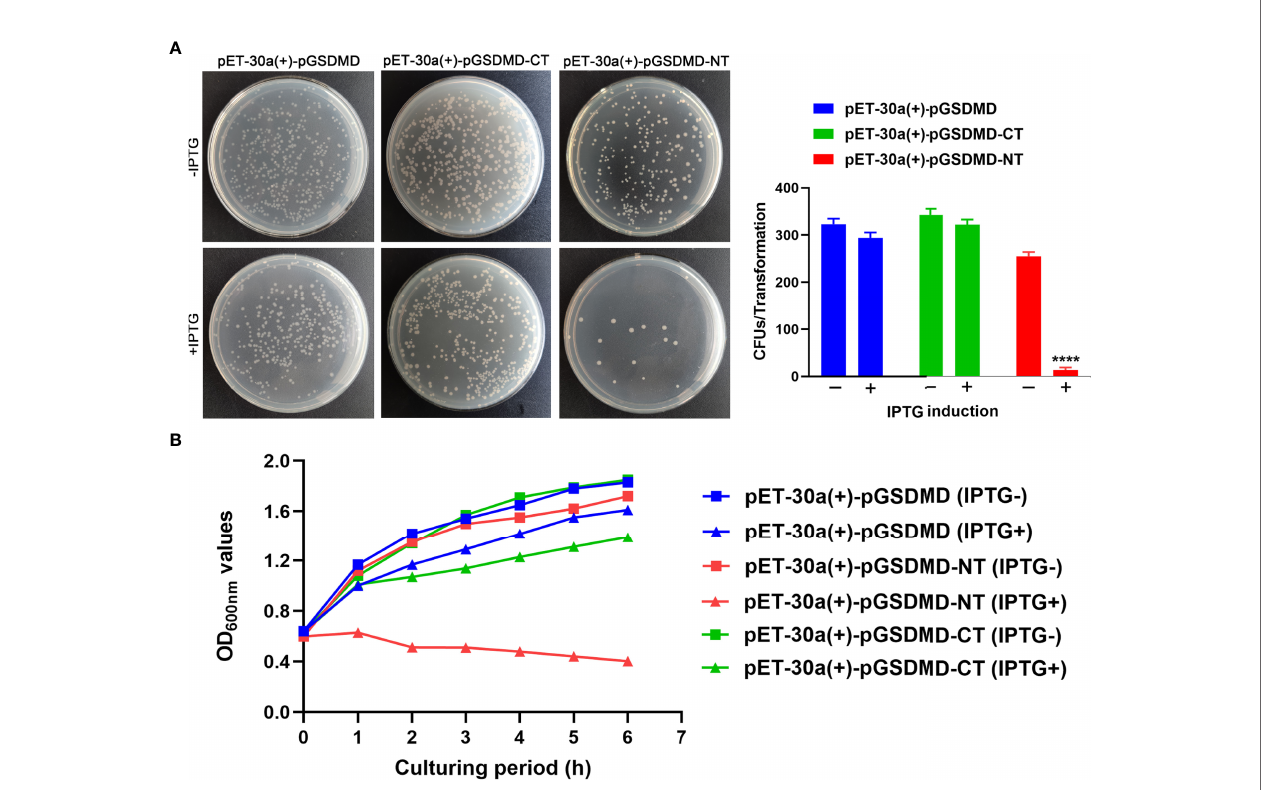
FIGURE 7 | rpGSDMD-NT exhibits bactericidal activity. (A) E. coli that can express His-rpGSDMD, His-rpGSDMD-NT (1 – 279 residues) and His-rpGSDMD-CT (280 – 489 residues) grown on the plate s in the presence or absence of IPTG for 12 h. Left panel shows the representative pictures of the plates. The number of colonies on the plates were counted and statistically calculated (right panel). Values are the means of triplicates and shown as means ± SD. **** p < 0.0001. (B) The OD 600nm values of the liquid cultures of E. coli transformants expressing His-rpGSDMD, His-rpGSDMD-NT and